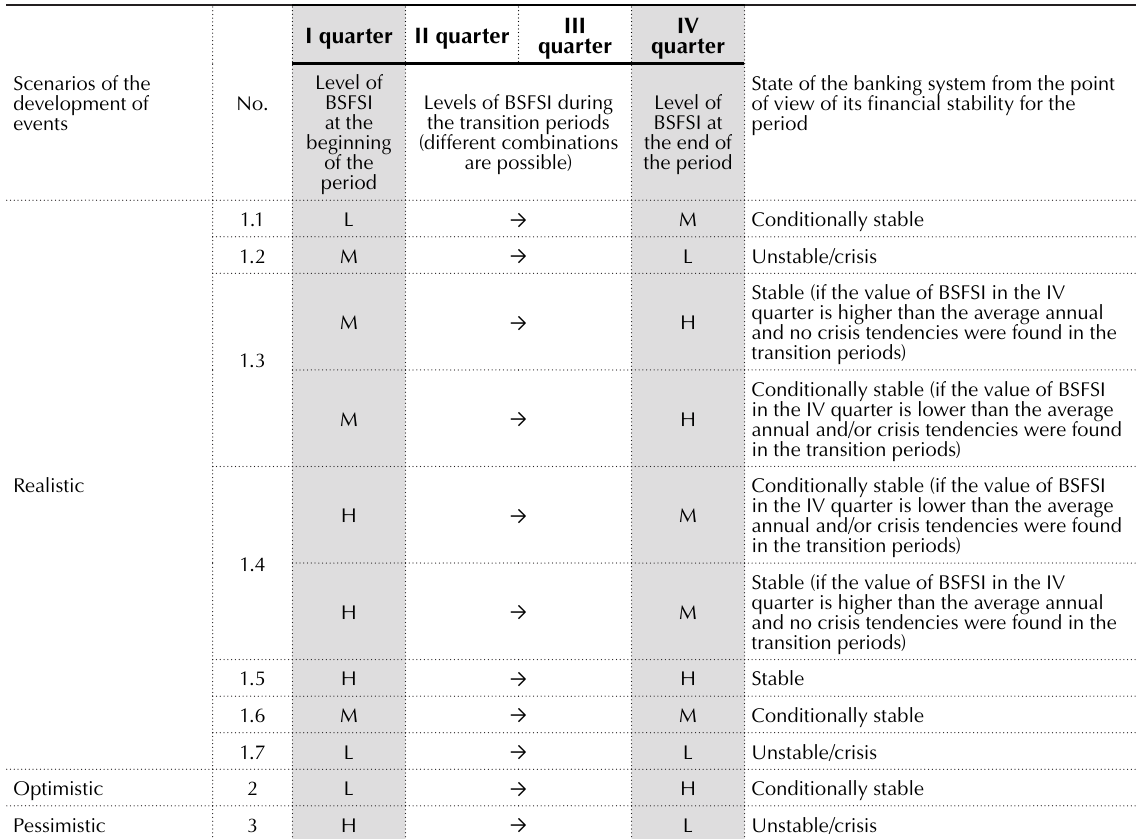
Table 1. Scenarios of the development of events concerning the change of quality levels of the banking system financial